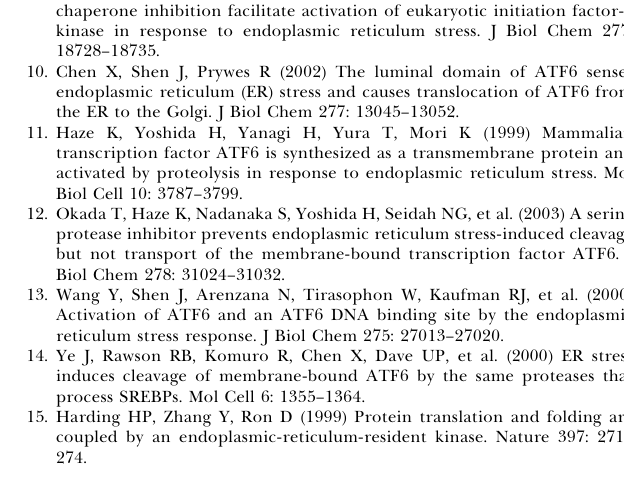
Figure S9. Atf4 , Chop , and Gadd34 mRNAs Are Unstable Expression of Atf4, Chop, Gadd34, BiP, Grp94, and p58 IPK mRNA in the presence or absence of ER stress and actinomycin D was quantitated by real-time RT-PCR as in Figure 5B. The data were normalized against 18S rRNA expression. The expression of each gene at the 0 hour time point for each stressor was set to ‘‘ 1. ’’ Error bars represent means 6 SDM from three independent plates. Found at DOI: 10.1371/journal.pbio.0040374.sg009 (291 KB TIF). Figure S10. Uggt1 Deletion Results in Up-Regulation of UPR Target Genes (A) The expression of mRNAs for BiP, p58 IPK , Chop, and Gadd34 in Uggt1 þ / þ and Uggt1 (cid:1) / (cid:1) MEFs was quantitated by real-time RT-PCR. Error bars represent means 6 SDM from RNAs harvested from three separate plates. (B) E10.5 embryos were harvested from a Uggt1 þ / (cid:1) ; Uggt1 þ / (cid:1) cross, and total RNA from whole embryos was prepared for real-time RT-PCR as above. Embryo genotype, determined by PCR from embryonic tissue, was confirmed by Uggt1 real-time RT-PCR primers, which provide a semi-quantitative assessment of expression of Uggt1 mRNA. Found at DOI: 10.1371/journal.pbio.0040374.sg010 (308 KB TIF). Figure S11. Behavior of UPR Target mRNAs and Proteins in Response to a Stress Modeled after Treatment with 25-ng/ml TM Shown are the fluctuations of individual components within the ATF4-CHOP-GADD34 axis and ATF6-BiP axis in response to a modeled stress (shown at upper left), along with a merged plot showing all components together (lower right). Found at DOI: 10.1371/journal.pbio.0040374.sg011 (732 KB TIF). Figure S12. Behavior of UPR Target mRNAs and Proteins in Response to a Stress Modeled after Treatment with 2.5 nM TG Same as Figure S11, except for 2.5 nM TG instead of 25-ng/ml TM. Found at DOI: 10.1371/journal.pbio.0040374.sg012 (660 KB TIF). Figure S13. Behavior of UPR Targets as a Consequence of Altering Degradation of CHOP Protein The degradation rate of CHOP protein was adjusted to match that of BiP protein within the 25-ng/ml TM context (i.e., Figure S11), and the effects on each component of the model were determined. Expression of CHOP, GADD34, and BiP proteins from this experi- ment is also shown in Figure 7D. Figure S14. Other Manipulations of Degradation Rates Within the 25-ng/ml TM context, the degradation rates of CHOP and GADD34 mRNAs and proteins were individually adjusted to match those of BiP mRNA or protein. The effects of these manipulations on expression of CHOP and GADD34 protein levels are shown, to allow for comparison with Figure 7C and 7D. Top panel: Chop mRNA degradation adjusted to the rate of BiP mRNA; middle panel: Gadd34